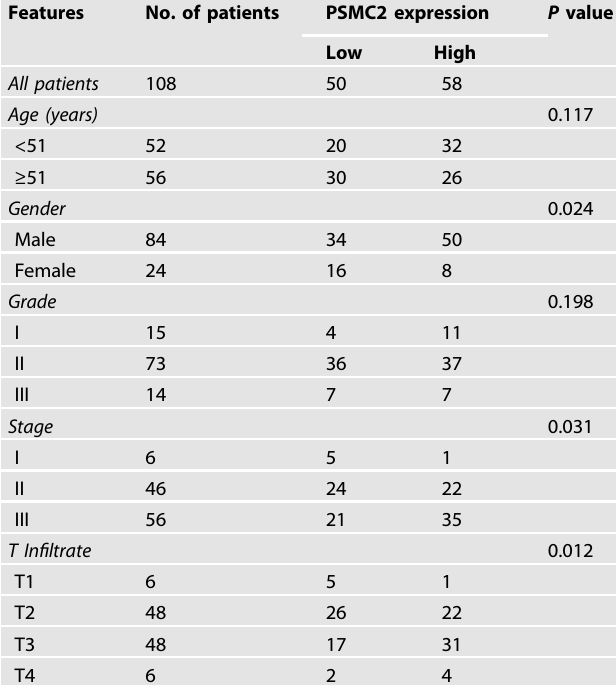
Table 2. Relationship between PSMC2 expression and tumor characteristics in patients with